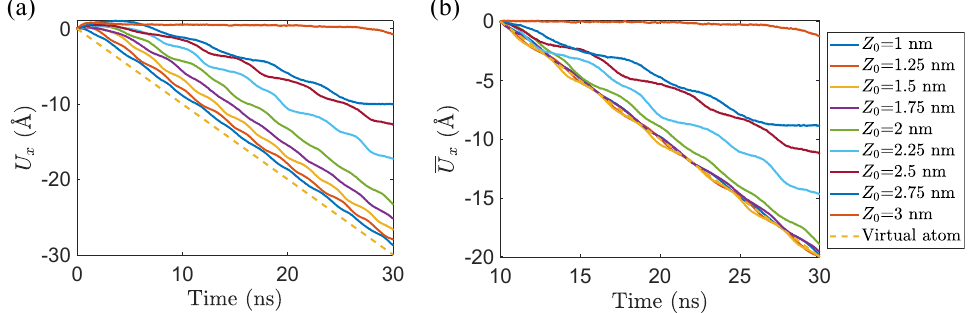
Figure 3. Displacement–time diagram of tail and virtual atoms of GNR with l x ∼ 9.2 nm, v d = 0.1 m/s and different lifting heights Z 0 . ( a ) considers the whole simulation time, including both stages I and II; ( b ) plots U x by choosing 10 ns as the zero displacement reference point, only involving stage